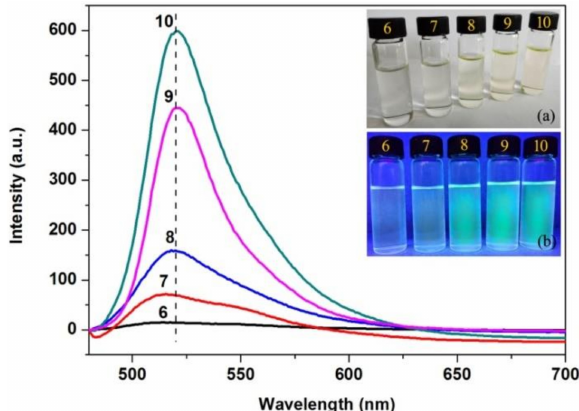
Figure 5. Fluorescence emission spectra of AFCO at different pH, and the insets are the optical images of AFCO solutions at different pH: ( a ) under visible light and ( b ) under ultraviolet light.